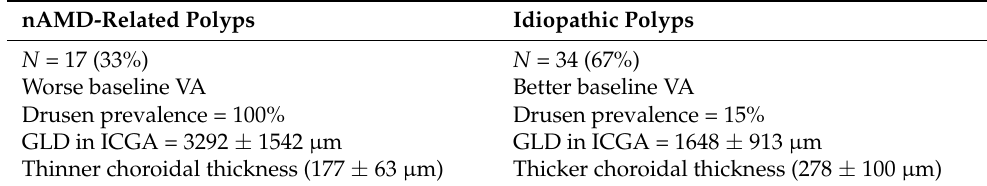
Table 4. Characteristics of eyes with nAMD-related polyps and eyes with idiopathic